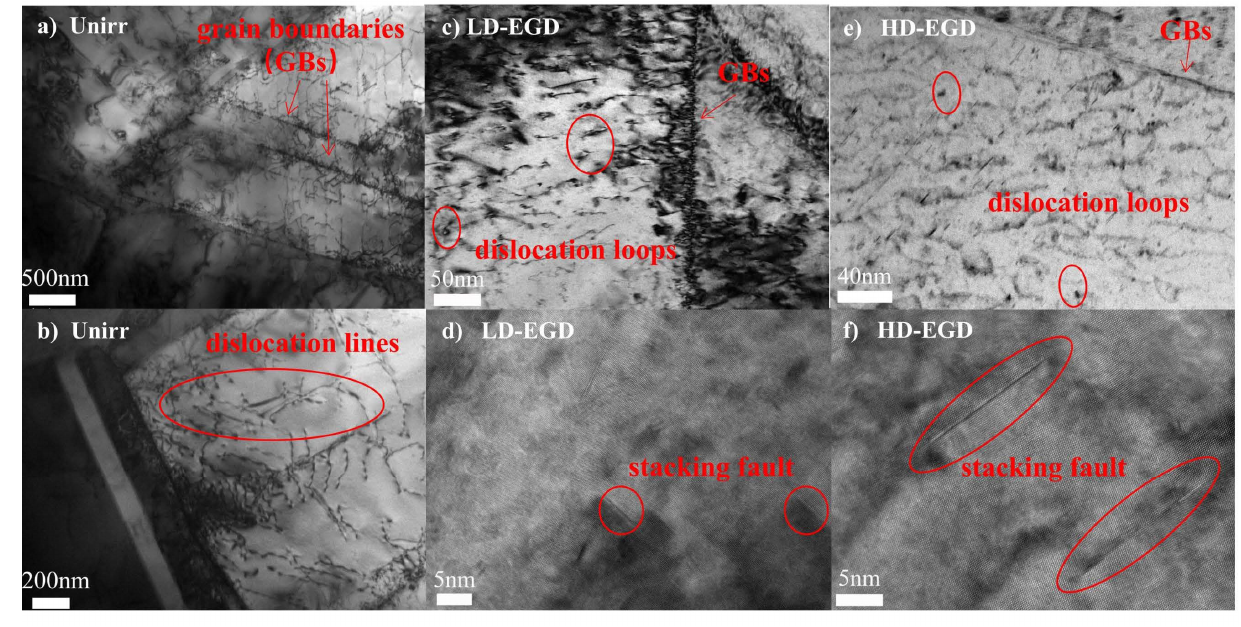
Figure 3. TEM characterization of different samples: ( a , b ) unirradiated sample, ( c , d ) low dose with energy gradient degrader (LD-EGD), ( e , f ) high dose with energy gradient degrader (HD-EGD).